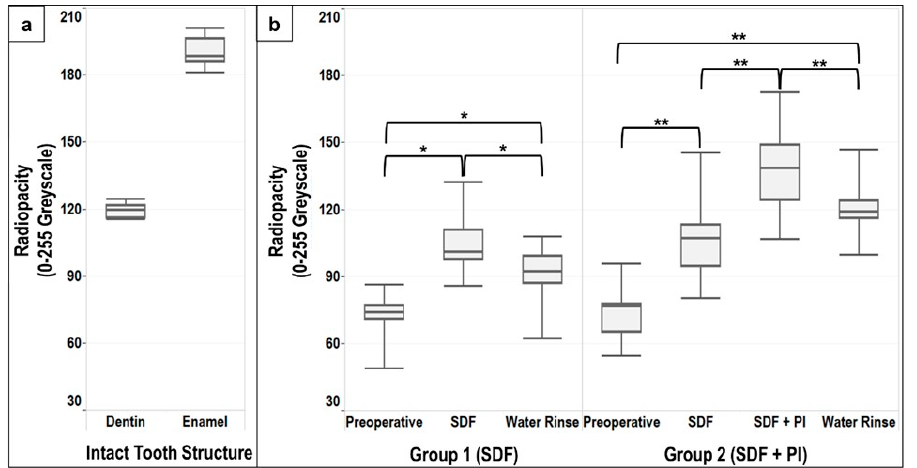
Figure 2. Pictures and coregistered 3D micro-CT reconstructions of sectioned teeth in Group 1 (SDF) and Group 2 (SDF + PI). ( a , A ) Preoperative images of a sectioned tooth showing carious lesions. ( b , B ) Preoperative micro-CT images showing radiolucent carious lesions. ( c , C ) Micro-CT images after application of SDF showing increase in the radiopacity of the carious lesions as well as silver precipitation on the external surface of the carious lesion (short white arrows). ( D ) Micro-CT images after application of PI showing increase in radiopacity likely due to the formation of silver iodide precipitation within the carious lesion (long white arrow). ( e , E ) Micro-CT images after 15 mL water rinse showing decrease in the radiopacity of the carious lesions compared to the same areas in ( c , D ) (outlined arrows). ( f , F ) One week post-operative images. ( f ) Dark staining of the carious lesion likely due to silver oxidation, and precipitation of silver at the junction of the affected and infected dentin (long black arrow), and penetration of the silver into the dentin tubules forming microwires (short black arrow). ( F ) Absence of dark stain in the Group 2 likely due to the formation of silver iodide.